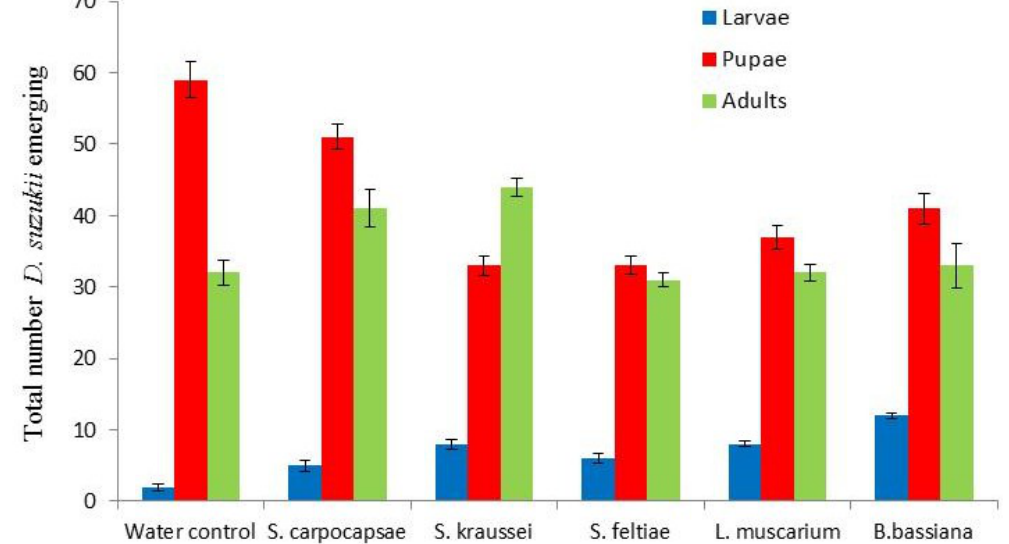
Figure 5. Impact of dipping infested berries in entomopathogenic nematodes and fungi on resulting fruit fly emergence following 10 days incubation at 25 °C. Total numbers from 44 berries per treatment.